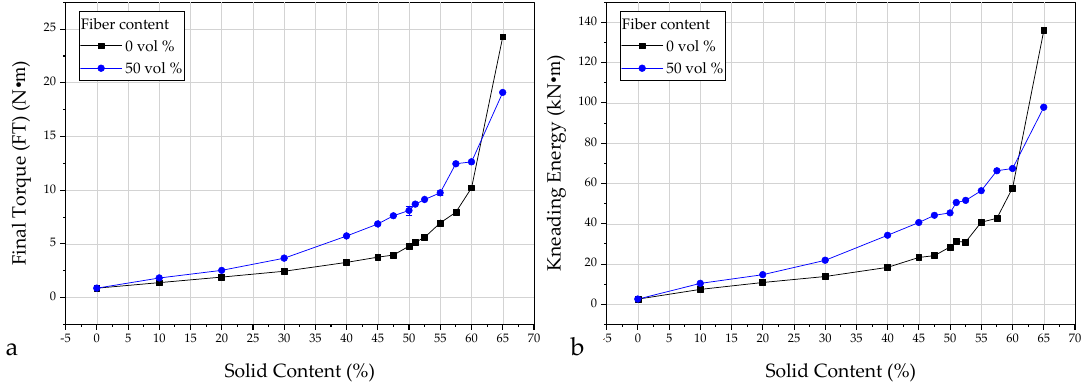
Figure 7. Effect of increasing solid content on ( a ) final kneading torque and ( b ) kneading energy.